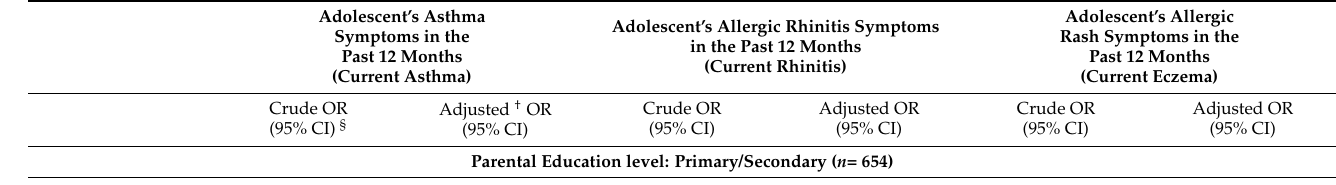
Table 4. Results from the multiple logistic regression analysis assessing the association between history of an atopic disease (asthma, rhinitis, eczema) in the past 12 months and adolescents’ lifestyle factors, adjusted for several confounders and all the remaining lifestyle factors according to their parental educational